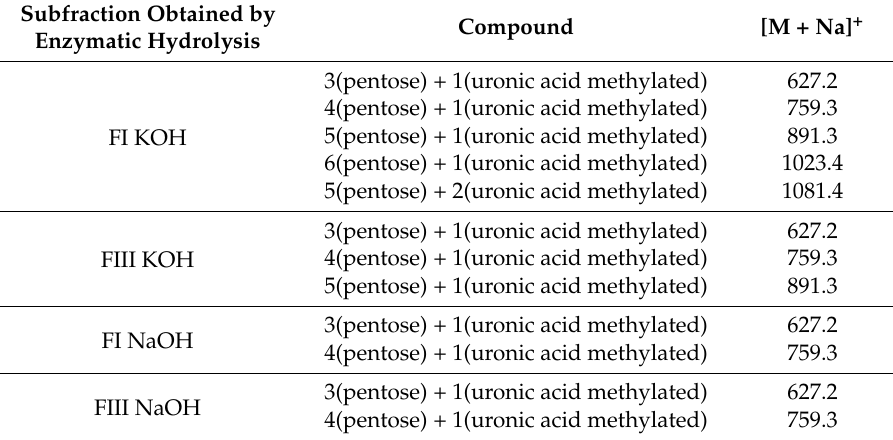
Table 5. Positive-ion mode matrix-assisted laser desorption ionization-time of flight mass spectrometry (MALDI-TOF-MS) of the oligosaccharides generated from the hemicellulosic fractions by hydrolysis with endo-xylanase.